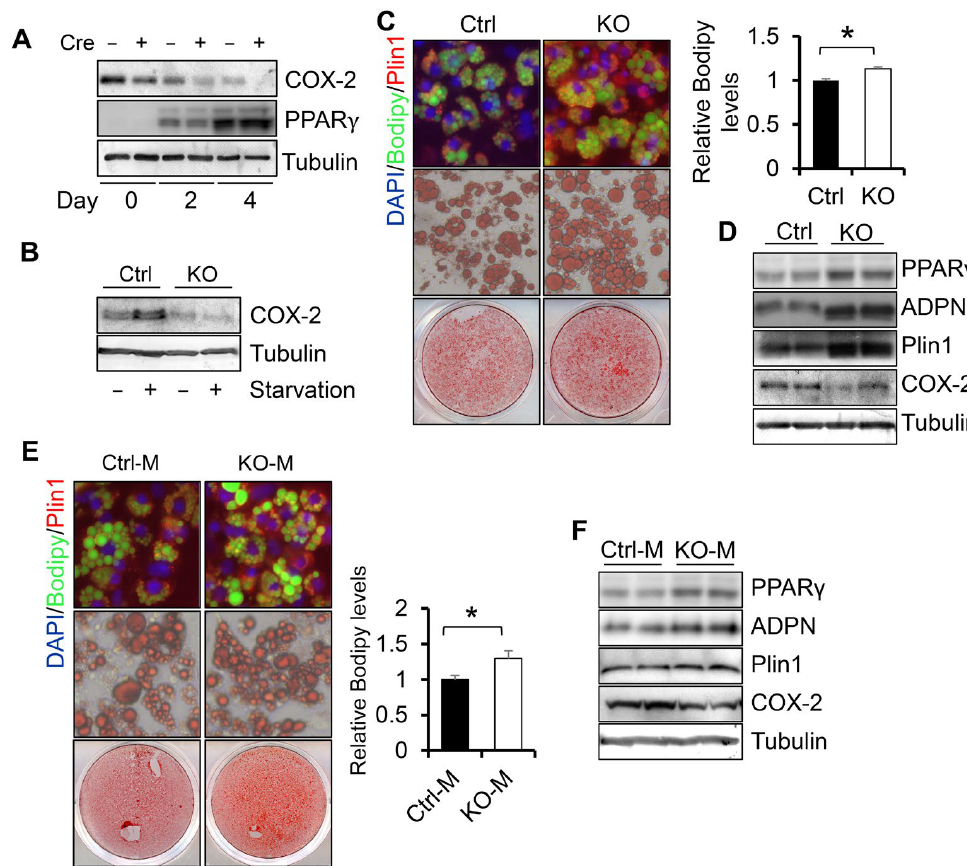
Figure 2. COX-2 deficiency enhances white adipogenesis. The stromal vascular fractions were isolated from white adipose tissue, cultured, and differentiated into adipocytes. ( A ). The expression levels of COX-2 and PPAR γ in COX-2 KO and control cells during differentiation. ( B ). COX-2 was induced by starvation in control adipocytes but not in COX-2 KO cells. ( C ). COX-2 depletion enhanced white adipogenesis as presented by fluorescence staining of Bodipy, Plin1, and DAPI, and Oil red O staining in primary cells. On day 6, differentiated COX-2 KO and control cells were stained with antibodies of Bodipy and Plin1 or Oil red O. The relative levels of Bodipy were quantified. ( D ). Expression levels of adipogenic markers PPAR γ , adiponectin, and Plin1 were significantly induced by COX-2 deficiency in day 6-differentiated primary adipocytes. ( E ). The media from primary COX-2 KO adipocytes increased the ratio of differentiation in control cells as presented by Oil red O staining and fluorescence staining of DAPI, Bodipy, and Plin1 in primary cells and quantitative of the relative Bodipy levels. ( F ). Expression levels of adipogenic markers PPAR γ , adiponectin, and Plin1 were slightly induced by the treatment of COX-2 deficiency media in day 6-differentiated primary adipocytes. Figure 2A–F are the representative data from three independent experiments. T-Test was used for the analysis in Figure 2C,E. * p <